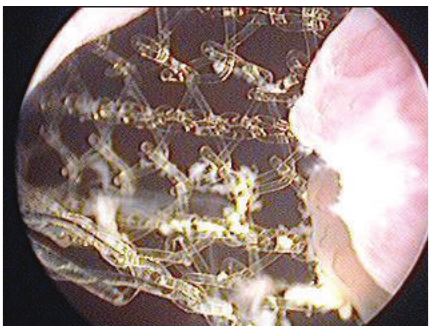
Figure 2: Open cystotomy through suprapubic approach, the mesh above the Foley catheter (under the